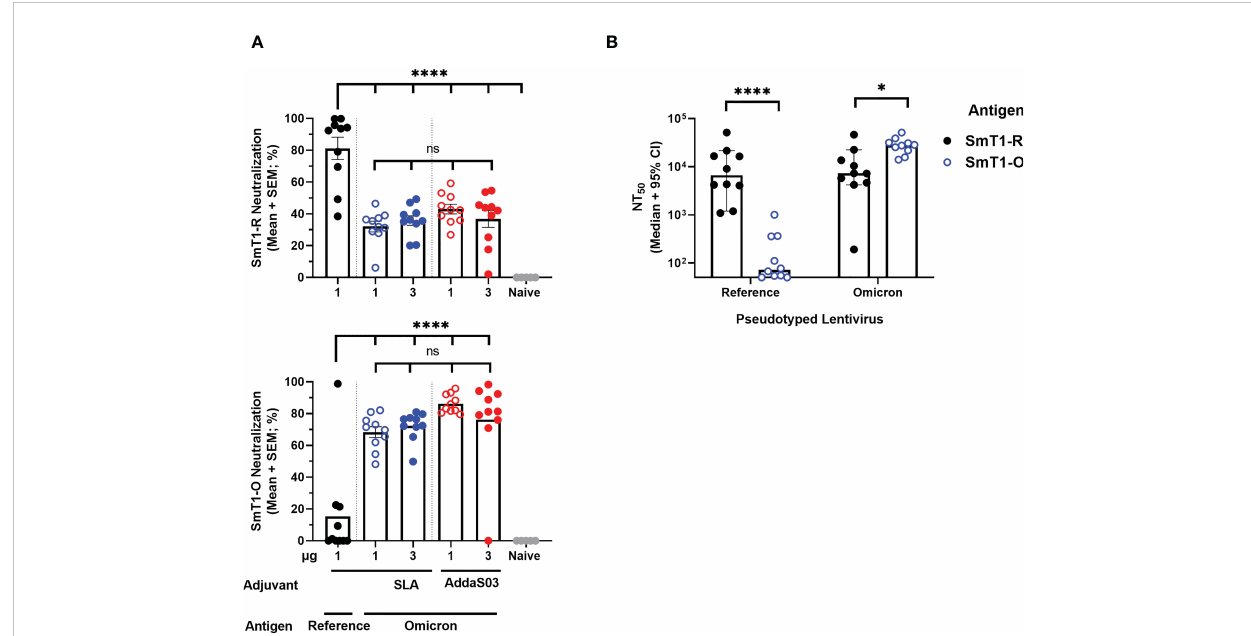
FIGURE 3 Neutralization activity towards Omicron Spike is stronger in sera of mice immunized with SmT1-O vs . SmT1-R-based vaccine formulations. C57BL/6 mice (n=10/group) were immunized i.m. with SmT1-R or SmT1-O adjuvanted with SLA or AddaS03 on days 0 and 21. (A) Serum was collected on Day 28 and analyzed by surrogate cell-based SARS-CoV-2 spike-ACE2 binding assay at a dilution of 1 in 75 for neutralization activity against the reference strain using SmT1-R (top) and the Omicron strain using SmT1-O (bottom). (B) Serum from mice immunized with the SLA-adjuvanted formulations containing 1 µg SmT1-R or SmT1-O antigens were also assessed for neutralization activity against lentivirus pseudotyped with either reference (Left) or Omicron (Right) SARS-CoV-2 spike. Statistical signi fi cance of differences among groups receiving SmT1-O vaccine formulations as well as these groups vs . the control dose of SmT1-R are shown: ns = not signi fi cant, *p<0.05 and ****p<0.0001 by one-way ANOVA followed by Tukey ’ s multiple comparisons test (A) or by unpaired Student ’ s t-test followed by Welch ’ s correction (B)